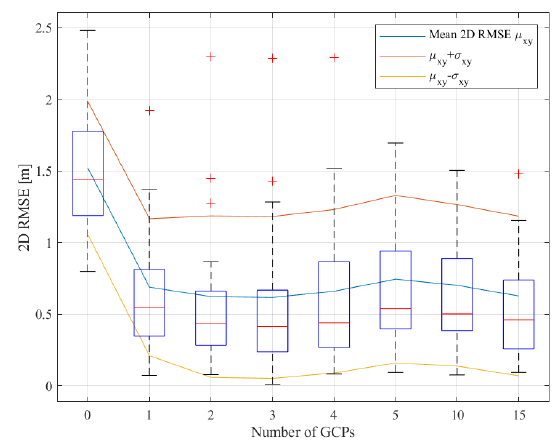
Figure 6 – Planimetric model accuracy: 2D RMSE (17 CPs) vs number of GCPs